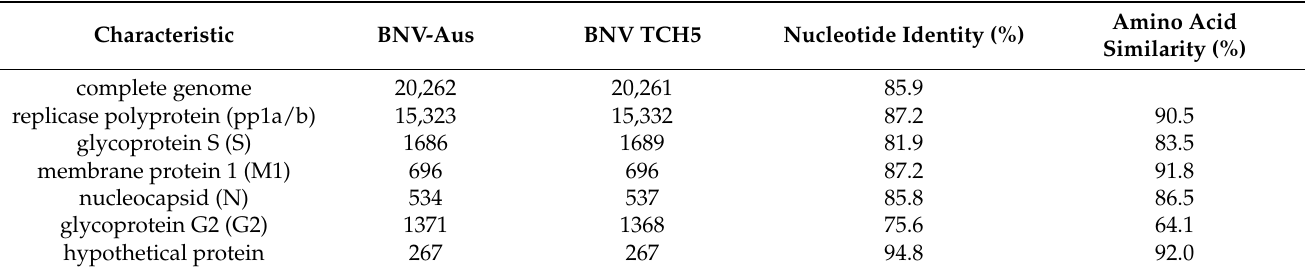
Table 4. Comparison of the Australian bovine nidovirus (BNV-Aus) genome sequence to the reference BNV genome sequence of strain TCH5.